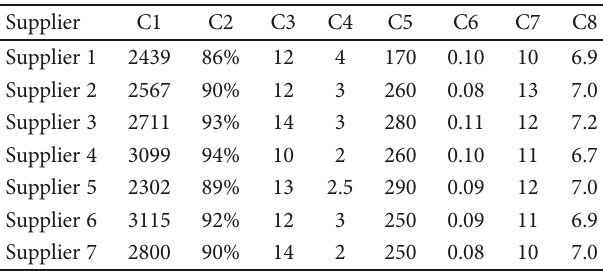
Table 2: Alternatives versus